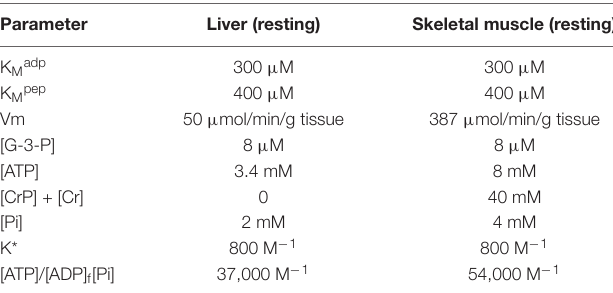
The simulations for flux through PK were based on the parameter values listed in this table. The values are for resting tissue and [Pi] has been decreased (4.76 to 2 in liver; 8 to 4 in skeletal muscle) to partially correct for binding as indicated by 31 P MRI (Iles et al.,